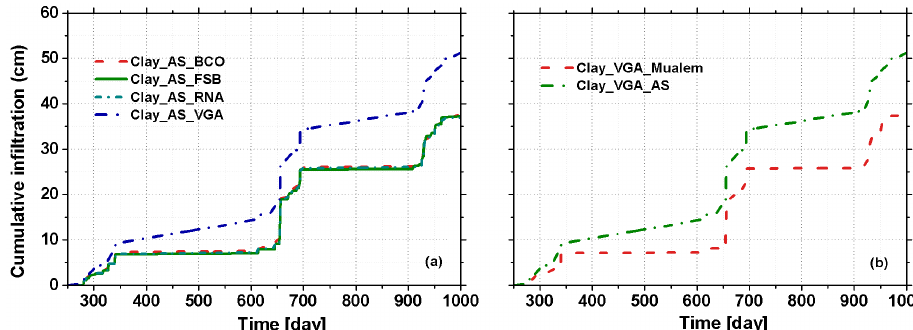
Figure 18. As in Fig. 15, for clay.